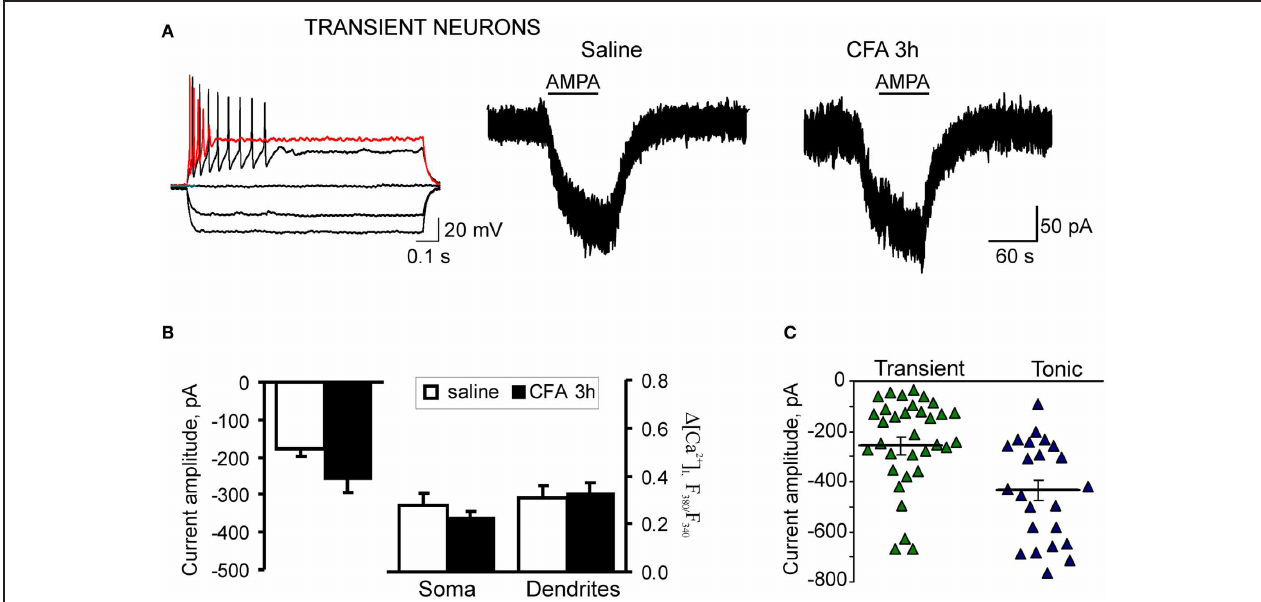
neurons3 hafterinjectionofsalineorCFA.Nosignificantdifferencewasfoundin allmeasuredparameters. (C) Thescatterplotillustratesaspreadin AMPA-inducedcurrentsinthetonic(blue)andtransient(green)neurons3 hafter CFAinjection.DifferenceintheamplitudesofAMPA-inducedcurrentsbetween thetransientandtonicSGneuronswassignificantintheCFA-inflamedgroup ( p < 0 . 01),butnotsignificant3 hpost-saline( p > 0 . 05).